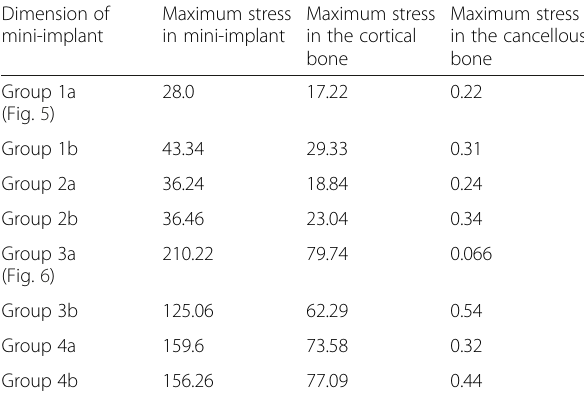
Table 4 Maximum von Mises stress (MPa) for force simulating anterior intrusion and retraction force Dimension of mini-implant